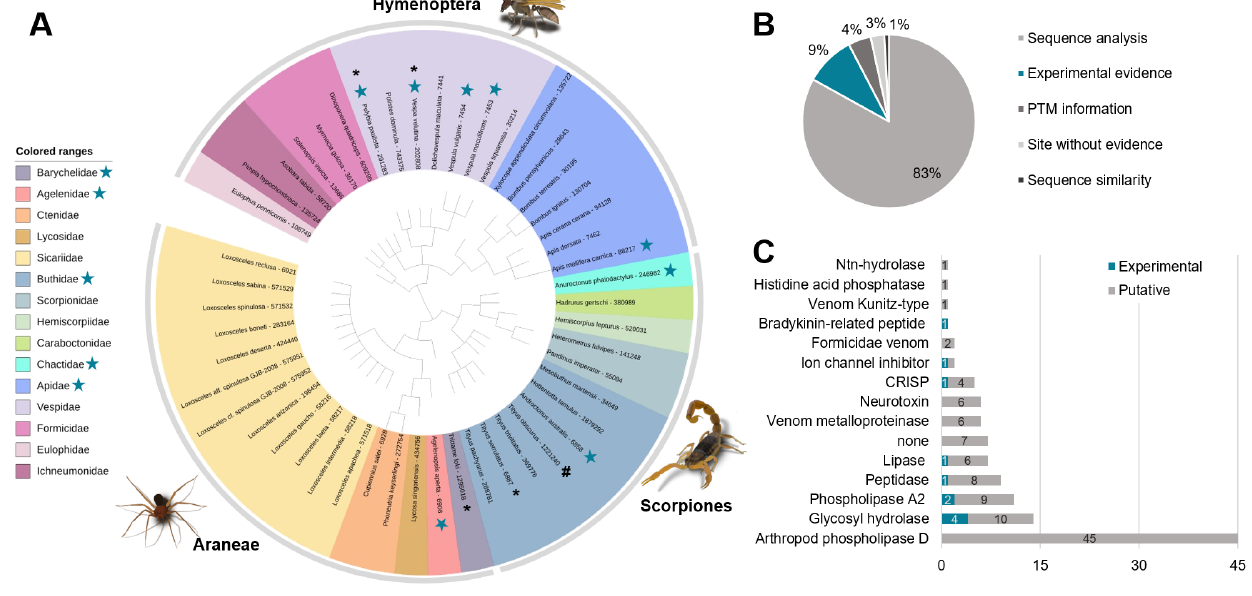
Figure 3. Arthropod venom proteins glycosylation and phosphorylation from UniProtKB/Swiss-Prot Protein Database. (A) Phylogenetic tree of arthropods species that contains phosphorylation and glycosylation information in the database. The species are grouped in colored range by Family taxonomy and the outer circle shows the Order they belong to.  Species containing proteins with both glycosylation and phosphorylation information. # Species with proteins presenting only phosphorylation information.  Family and species with experimental glycosylation and/or phosphorylation. (B) The database contains different evidence of 118 protein entries containing glycosylation information. (C) Distribution of 111 glycoproteins (experimental and putative) among different protein families provided by Uniprot based on the InterPro database